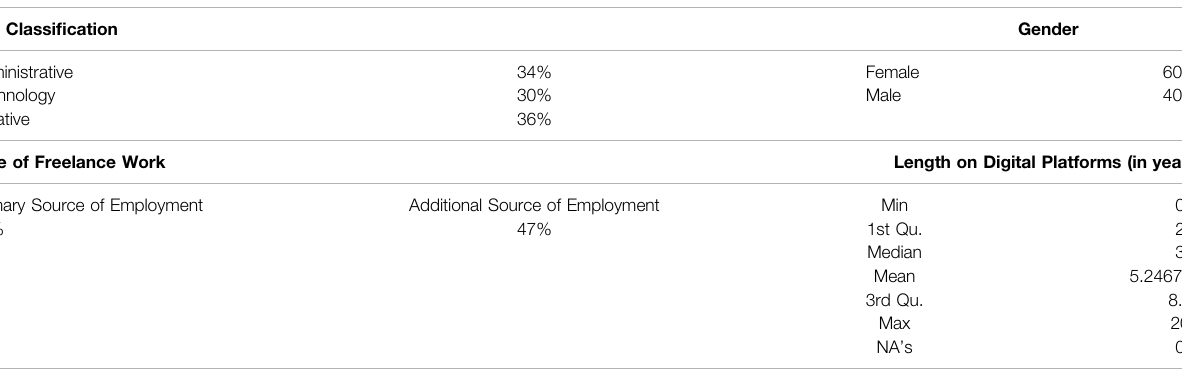
TABLE 1 | Summary